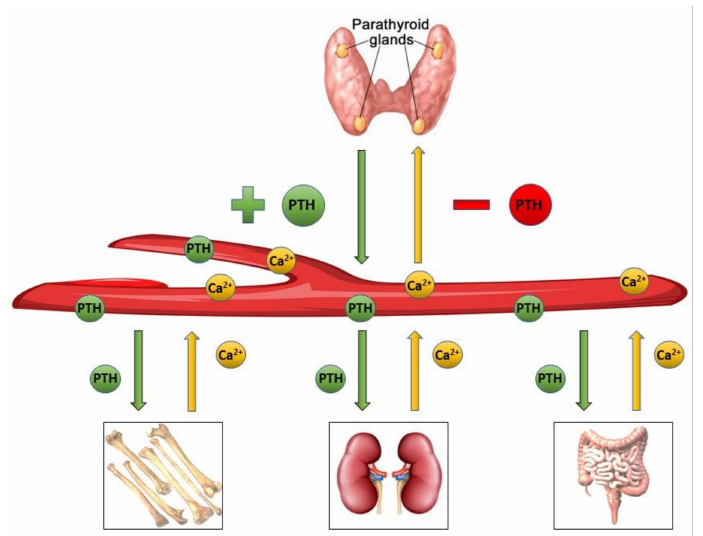
Figure 1. Serum PTH levels are tightly regulated by a negative feedback loop. PTH is secreted by the parathyroid glands as serum calcium levels drop, inducing the bones to release more ionic calcium and stimulating the kidney and intestine to reabsorb calcium. The release of PTH is reduced as serum calcium levels